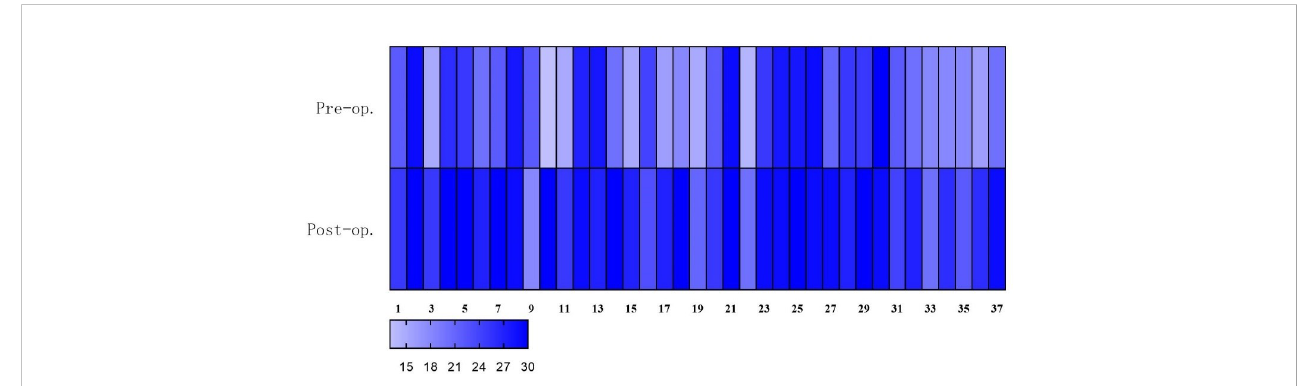
FIGURE 3 Heatmap: total scores of sexual function (IIEF scores) improved signi fi cantly postoperatively. Deeper color means higher scores.